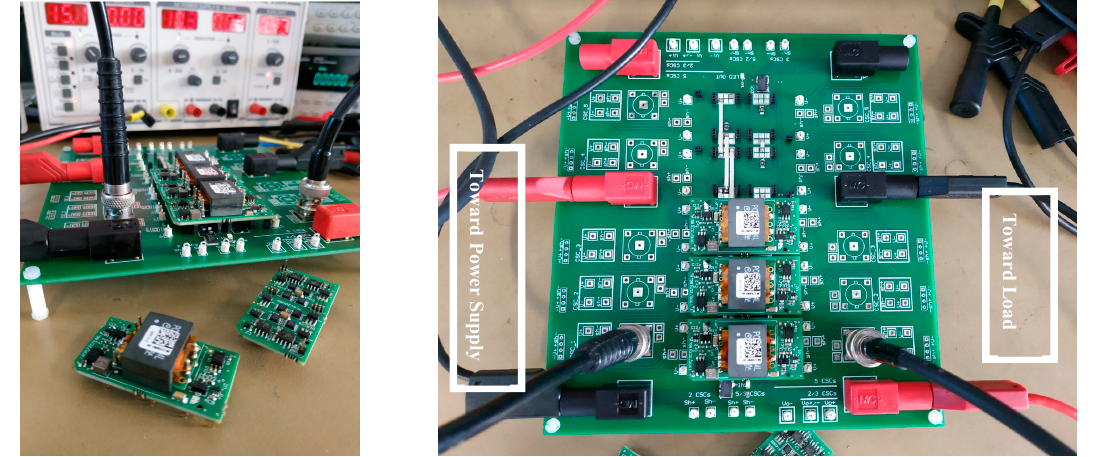
Figure 8. CSCs in front of test bench. Experimental setup test bench.